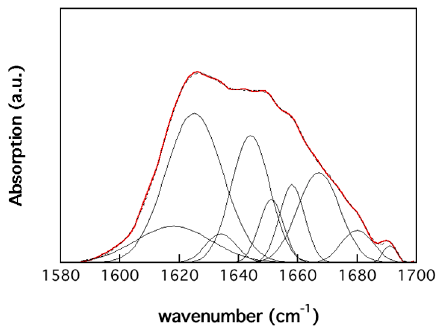
Figure 3. IR absorbance in the amide I region. The red and dashed curves correspond to the experimental and fitted curves, the latter made up of nine decomposed curves (Table 3).